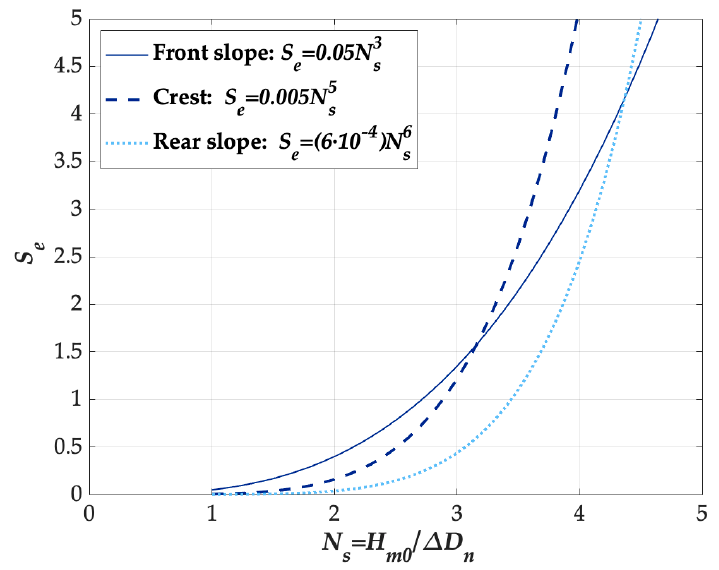
Figure 14. Comparison of the damage curves of the three armor sections for cube-2L.